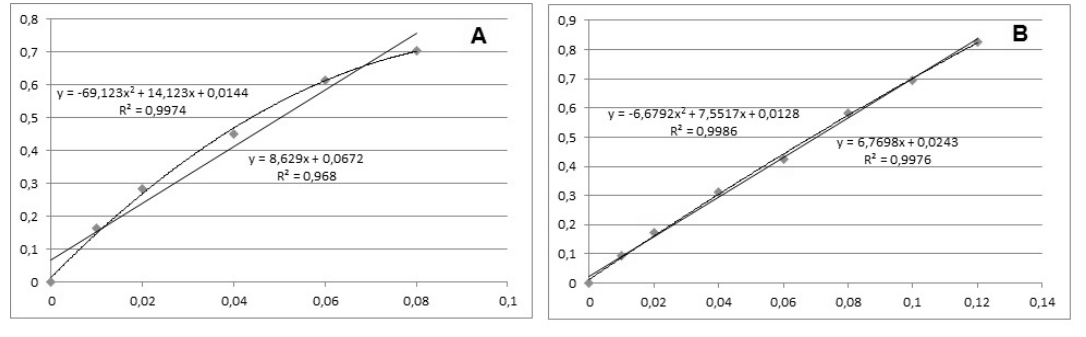
Figure 3. Calibration graphics: ( A ) Non-linear calibration graphics for Val-MEM; ( B ) Linear calibration graphics for Ala-MEM.